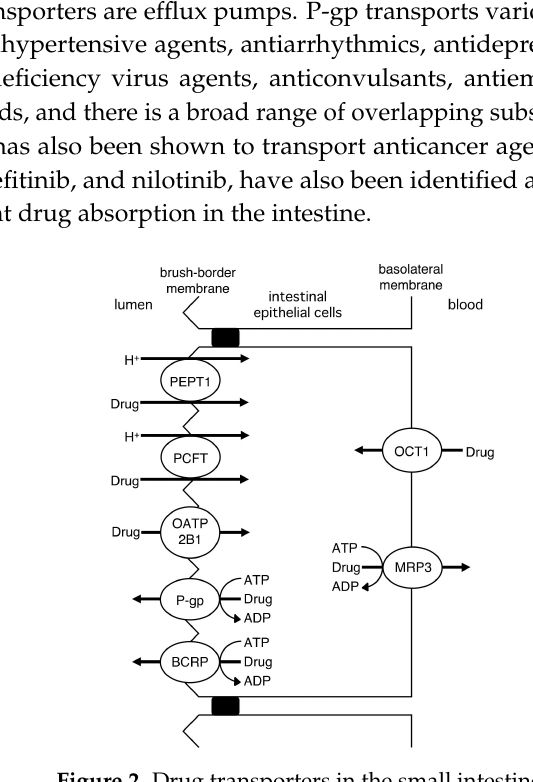
Figure 2. Drug transporters in the small